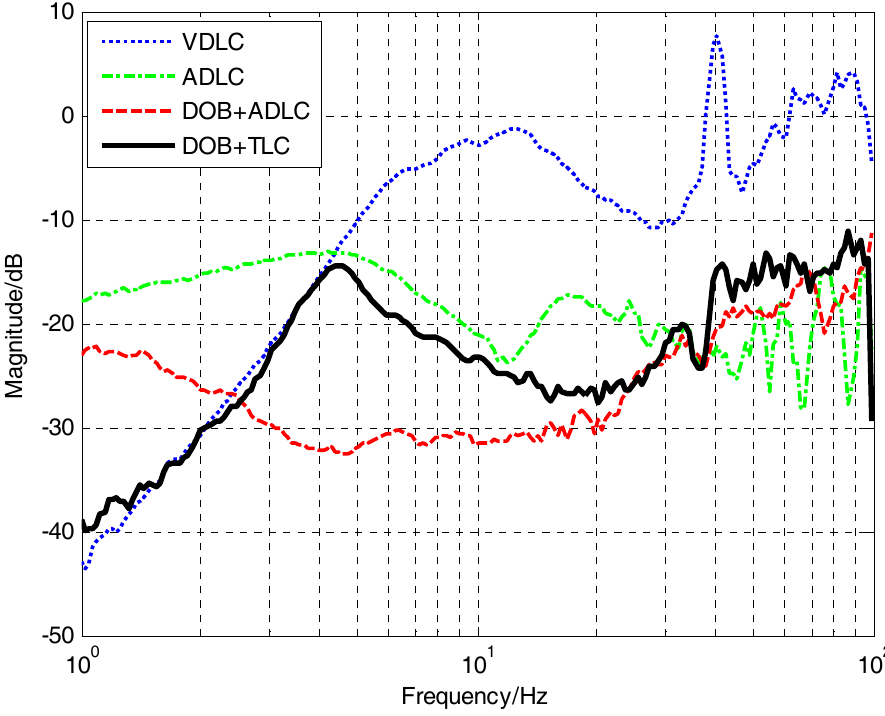
Figure 10. Disturbance attenuation of the four methods.